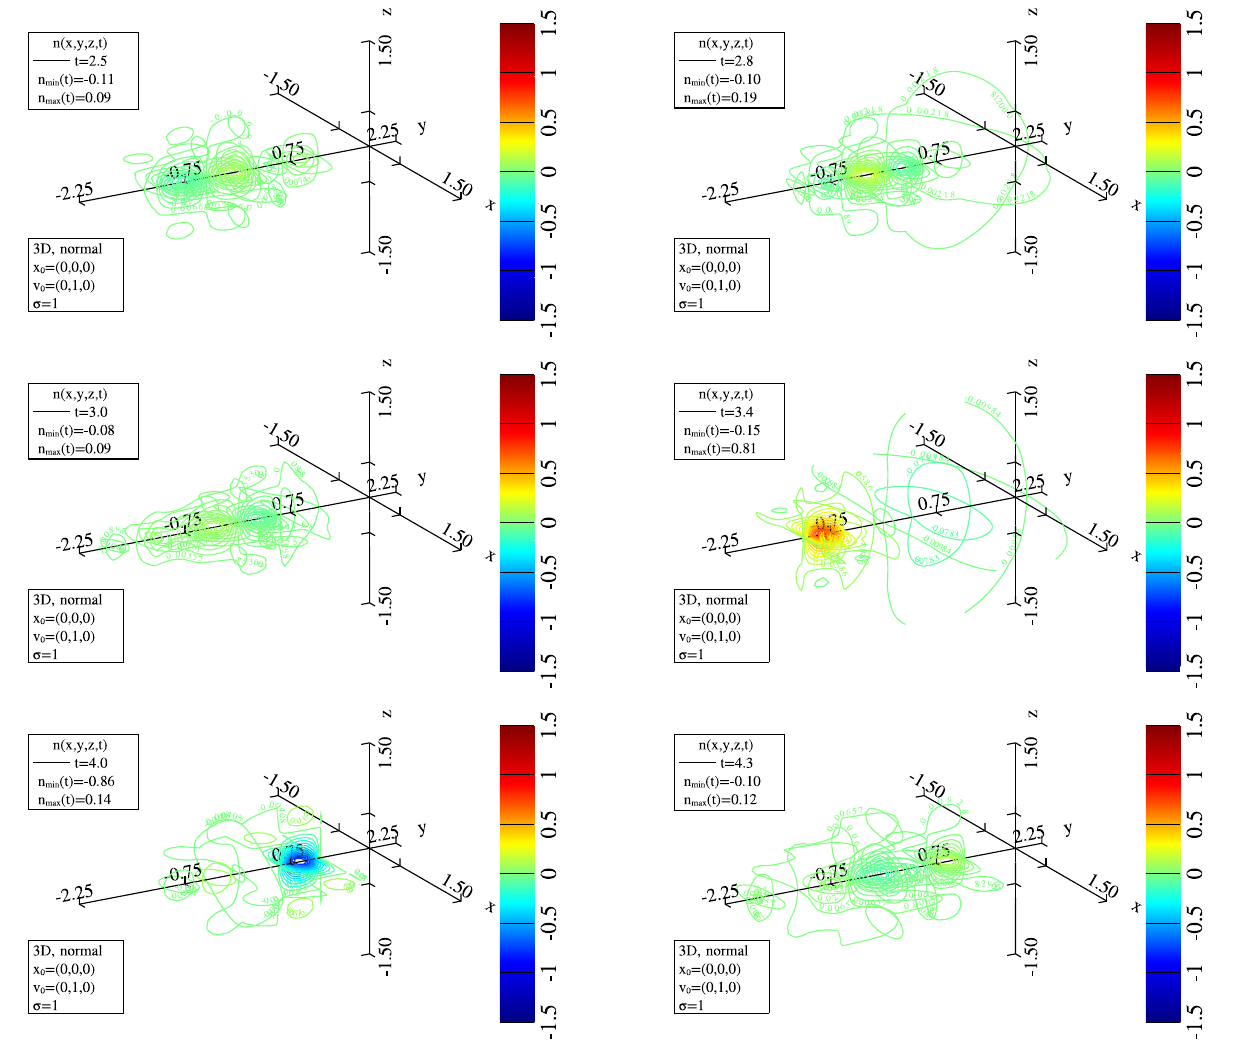
FIG. 9. Dynamics of the density n ð ~ x ; t Þ for the 3D plasma with normal spatial and velocity distributions for different values of time; the external charge starts moving from ~ x 0 ¼ ð 0 . 0 ; 0 . 0 ; 0 . 0 Þ with velocity ~ v 0 ¼ ð 0 . 0 ; 1 . 0 ; 0 . 0 Þ